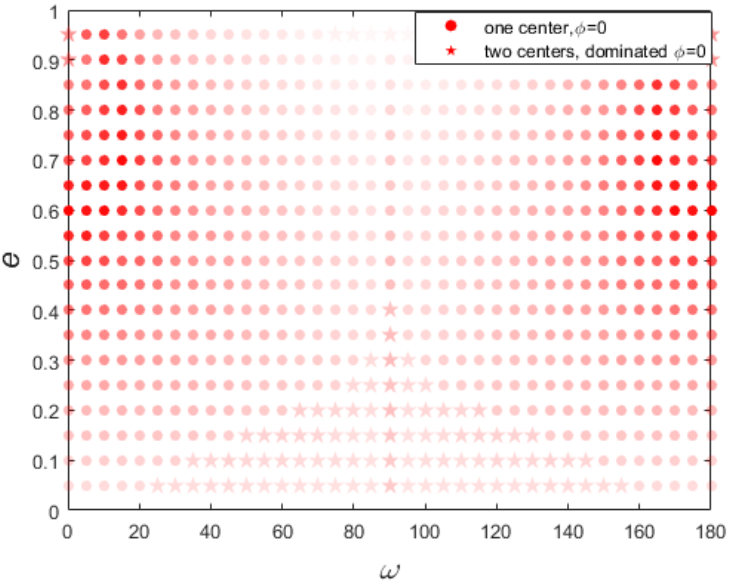
Figure 4. The scatter map of the resonant width of polar 2/1 resonance on the e − ω plane. The filled dots and pentagons represent their corresponding phase-space portraits that have one or two equilibriums, respectively. The color reflects the position of the libration center. The red means that the dominated libration center is around σ = 0 ◦ . In other cases, such as interior 2/3 resonance we will introduce later, there is a blue part, which means its dominated resonant equilibrium is around σ = 180 ◦ . The alpha of the marker represents the resonant width under the corresponding parameters. The higher the transparency, the narrower the resonant